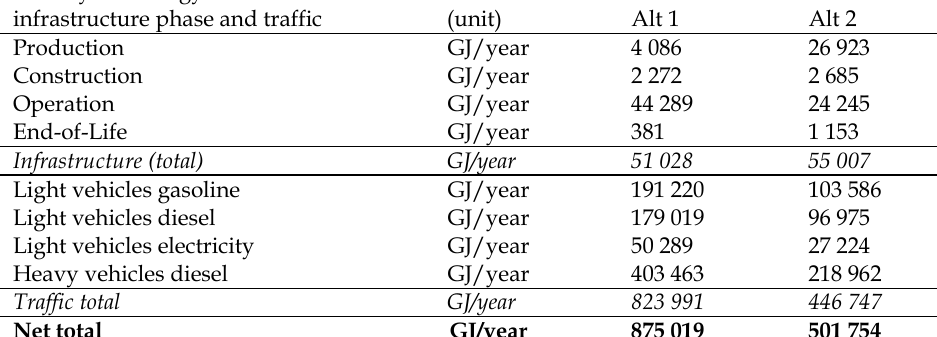
Table 5. Life cycle stage cumulative energy demand (CED) contributions Life cycle energy demand